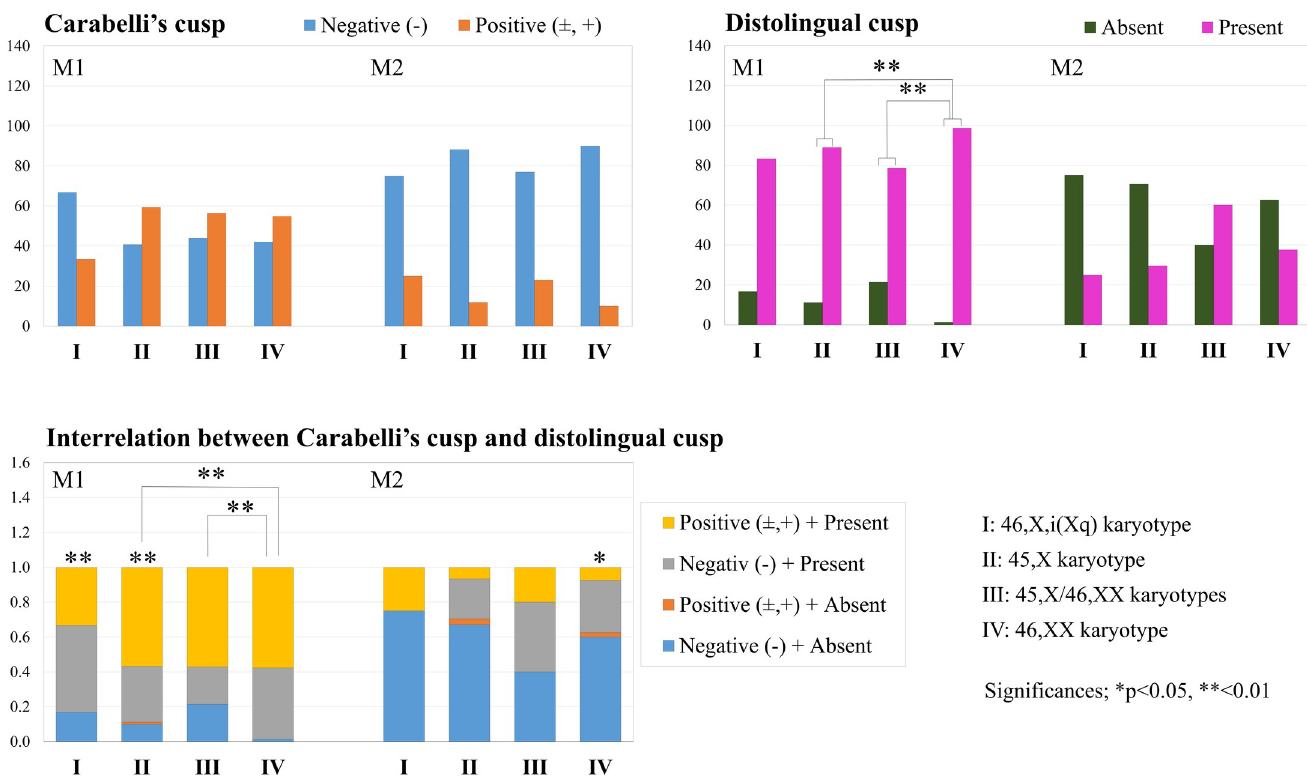
Fig 2. Frequency of Carabelli’s cusp and distolingual cusp and interrelation between two traits in the maxillary first (M1) and second (M2) permanent molars. Grades ( ± ) and (+) were combined into one grade ( ± , +) for the analysis. Fisher’s exact test was used to assess the difference in the appearance of Carabelli’s cusp or the distolingual cusp. The χ 2 test of independence was used to examine differences in the combination of Carabelli’s cusp and the distolingual cusp between